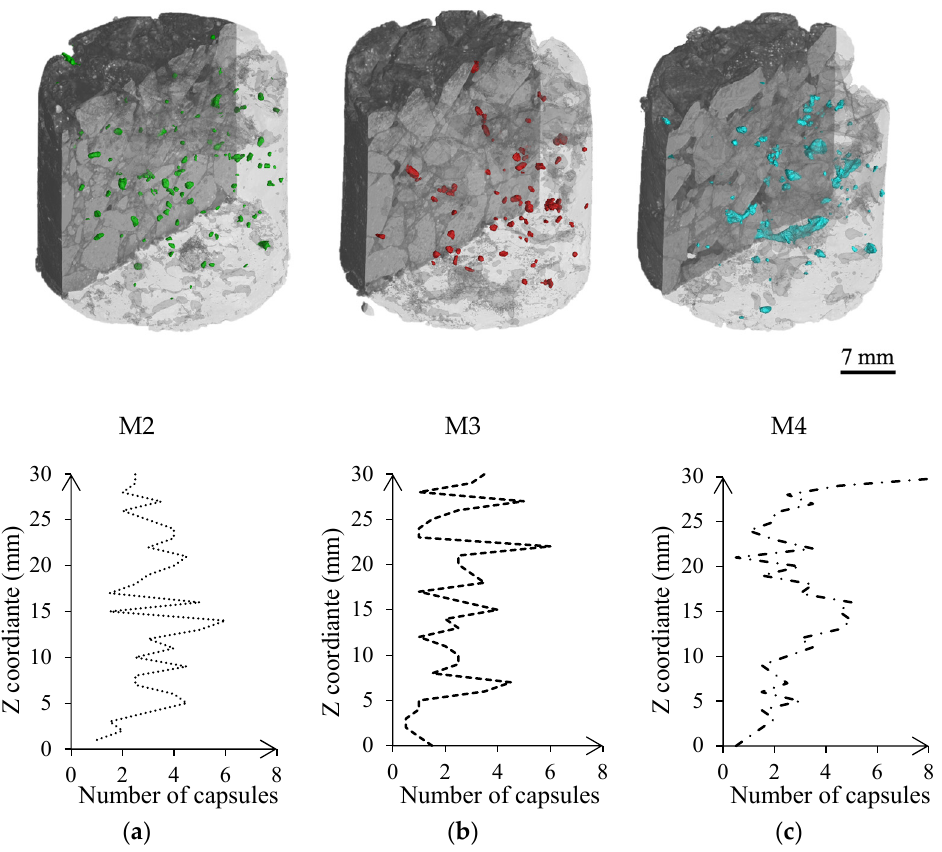
Figure 5. 3D reconstruction of plant-produced asphalt specimens containing capsules, from batches: ( a ) M2, ( b ) M3, ( c ) M4.